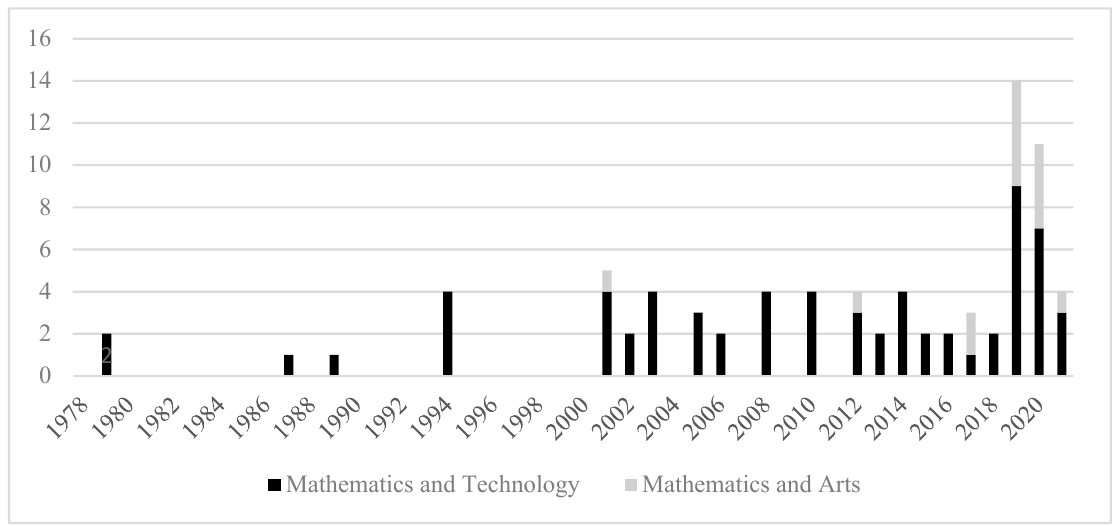
Figure 6. Histogram of the changes in the number of items in different sub-categories of the category of Interdisciplinary Connections